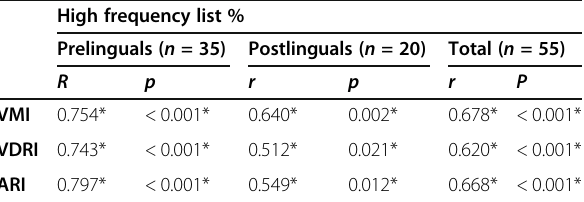
Table 7 Correlation between high frequency list scores with different indices of TOMAL – 2 test High frequency list